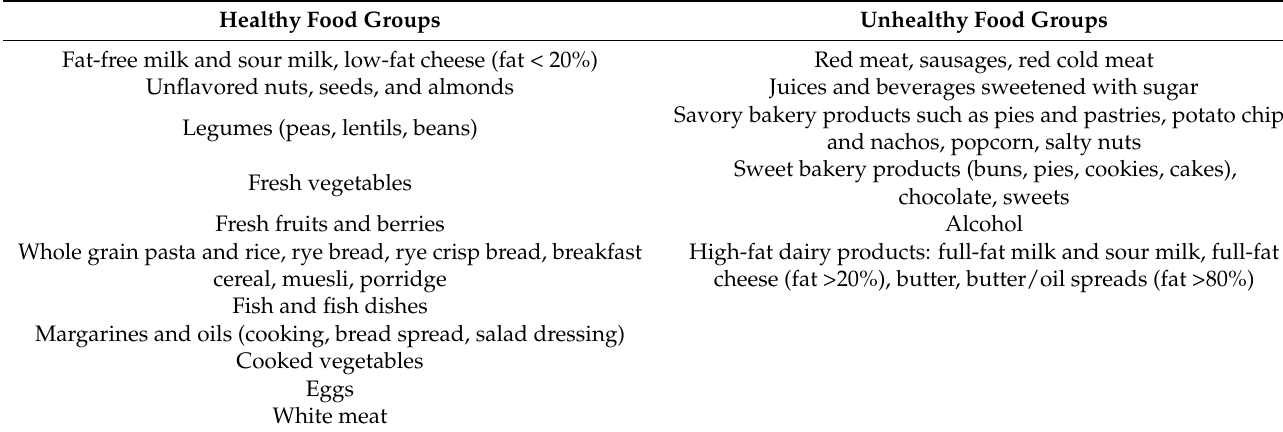
Table 1. Food groups considered healthy or